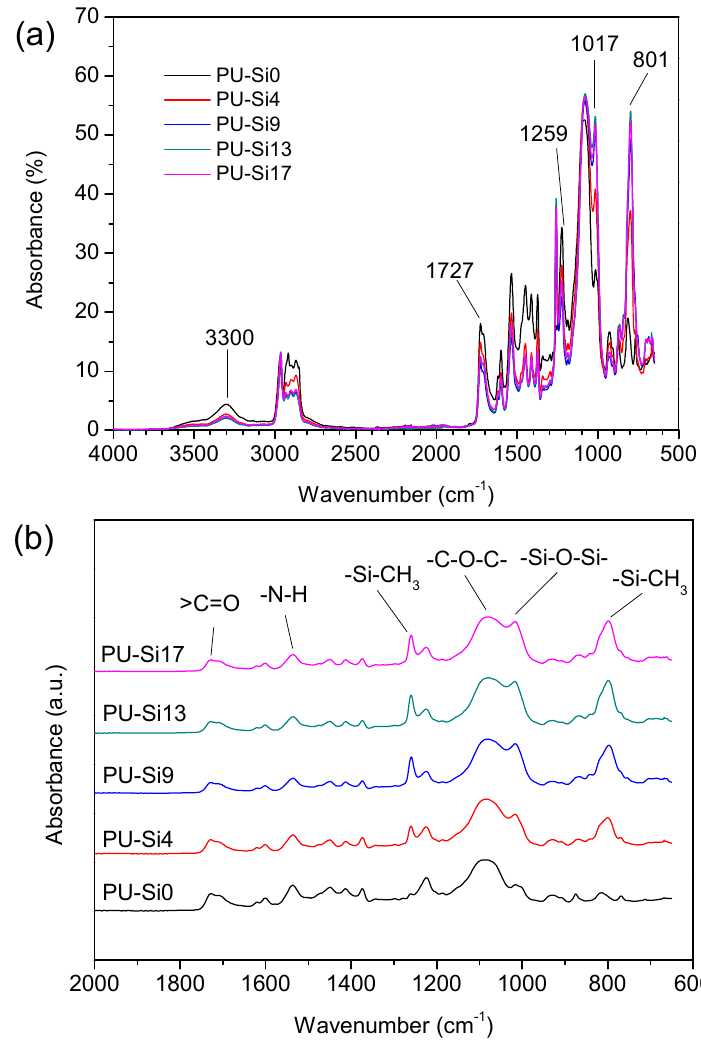
Figure 1. Fourier transform infrared (FTIR) spectra of the PU-Sis samples: ( a ) wave number from 4000 to 600, ( b ) wave number from 2000 to 600 local amplification of ( a ).